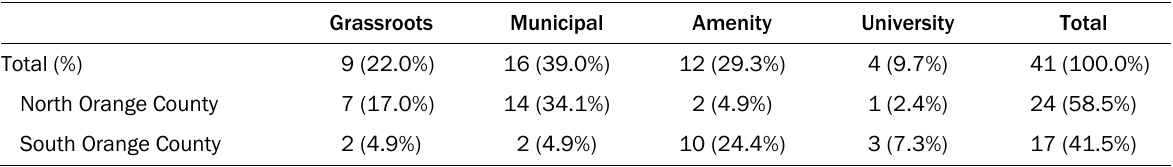
Table 3. Community Garden Types in Orange County, CA